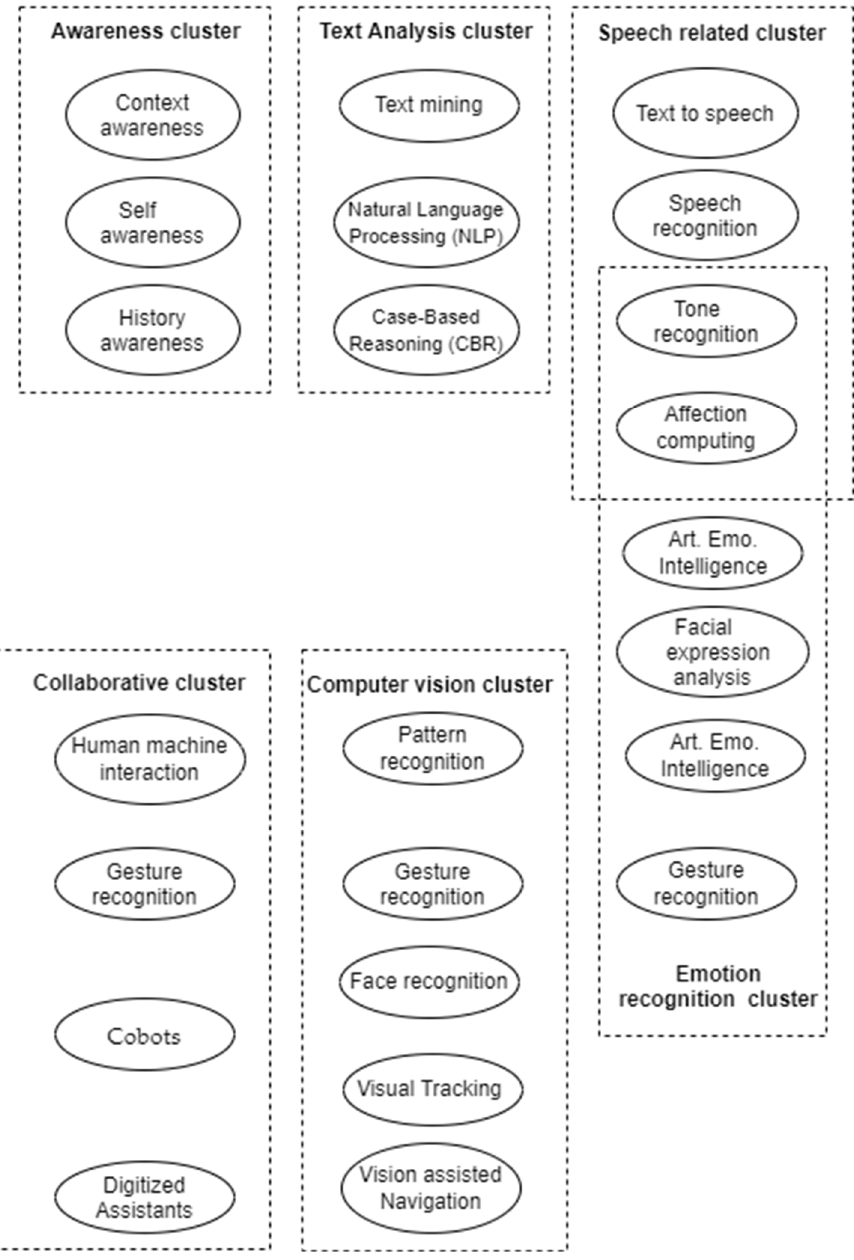
Figure 2. Clusters of major AI domain specializations in services and their relationships.